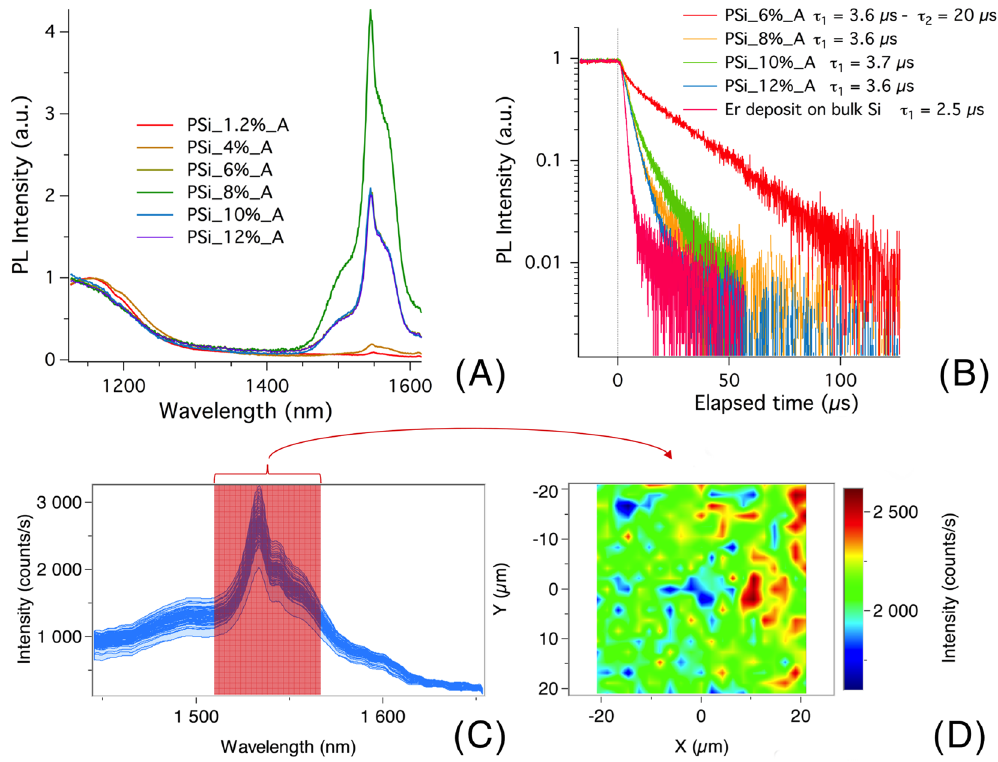
Figure 2. Photoluminescence results. ( A ) Normalized PL from annealed PSi samples with different Er content. ( B ) Decay time for the Er PL as a function of the Er content. The purple line with the shorter decay time has been measured from a thick Er-rich layer deposited on top of a bulk Si wafer using the same solution and doping current used for the doping of the porous samples. The deposition time in that case was 2000 s. ( C ) µ PL measurements of a PSi_8%_A. ( D ): bidimensional mapping of µ PL results shown in ( C ): − 20 to 20 µ m, step: 2 µ m, in the central area of the sample; acquisition time: 10 s (background corrected); the intensity of each point on the map has been taken as the integrated intensity over the red area in the corresponding